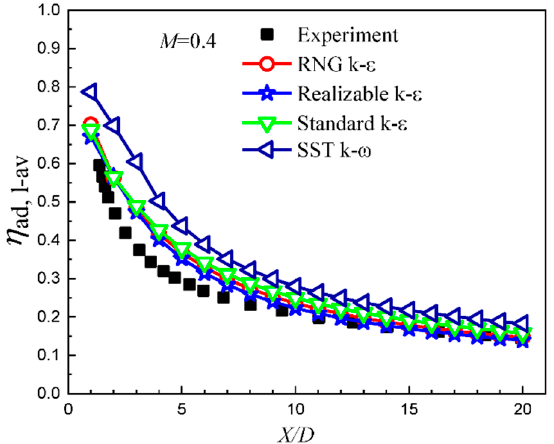
Figure 3. Validation of computational scheme for the SDR case (Experiment, Zhou et al. [22]).